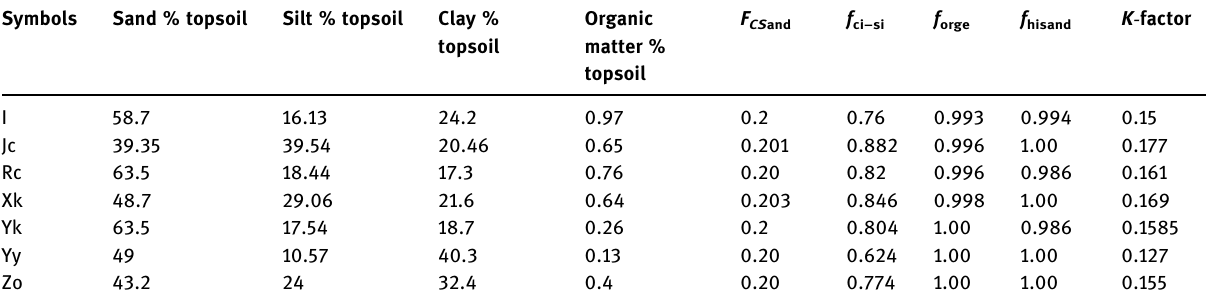
Table 2: Calculation of erodibility factor for case study topsoil Symbols Sand %